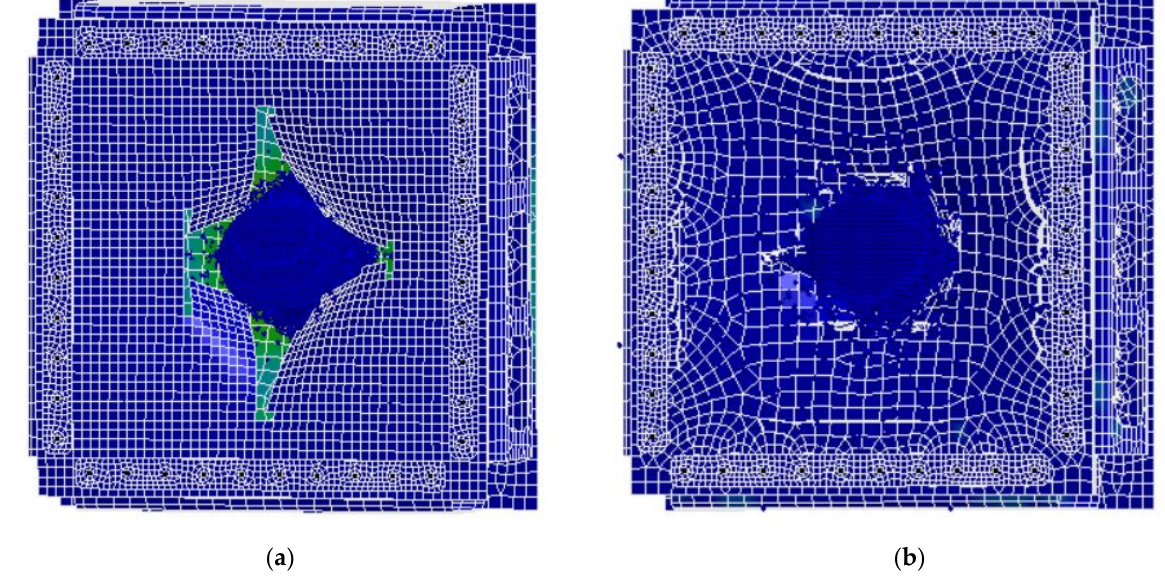
Figure 13. Meshes used for plexiglass plate: fine mesh ( a ) and coarse ( b ).